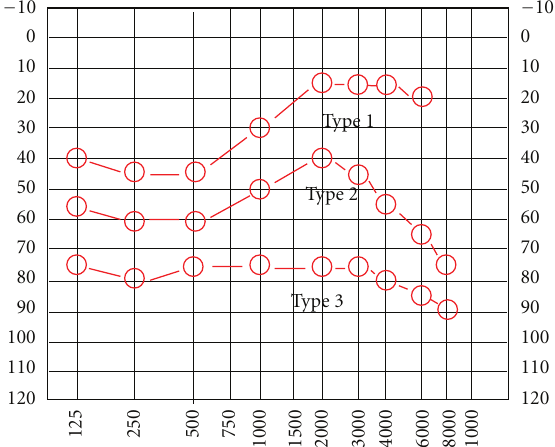
Figure 1: The 3 di ff erent types of audiometric exams; on x -axis are the represented frequencies, on y -axis, hearing loss in decibels